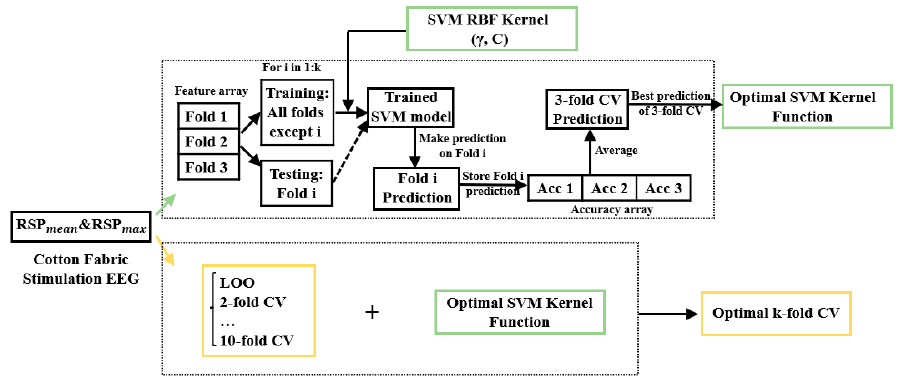
Figure 2. Configuration flowchart for the SVM-ML model. RSP: relative spectral power; SVM: support vector machine; RBF: radial basis function; Acc: accuracy; LOO: leave-one-out; CV: cross validation.